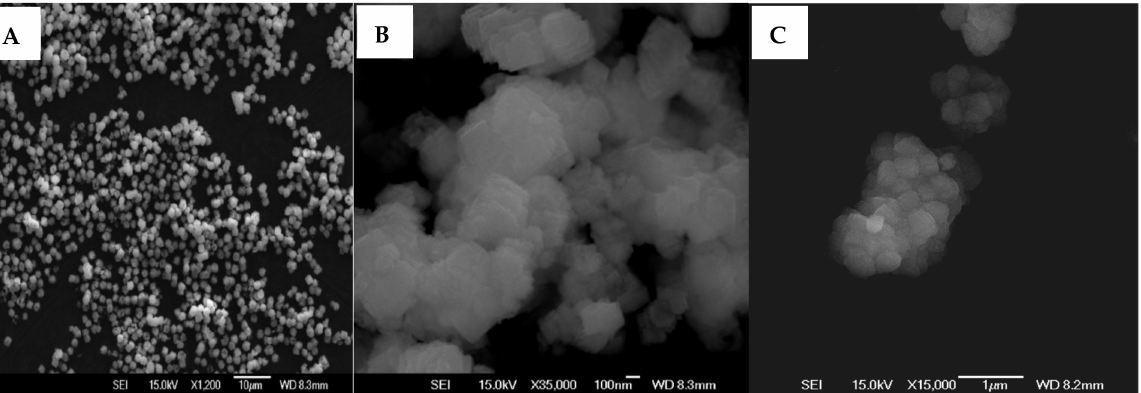
Figure 4. Scanning electron microscopy images of CaCO 3 microparticles obtained without alginate ( A ), with 0.5% MV alginate ( B ), and with 0.1% LV alginate ( C ). Scanning electron microscopy indicated that the rod-shaped structures formed in the presence of 0.5% LV alginate comprised a distinctive, complex hierarchical superstructure made of self-assembled, uniform, axially oriented, nanoscale, “flake-like” plates of CaCO 3 (Figure 5). The DNA loading efficiency, zeta potential, and hydrophobicity of the rod- shaped alginate-CaCO 3 microparticles were 95.2 ( ± 5.7)%, − 26.1 ( ± 0.4) mV, and 6.9 ( ± 2.7)%, respectively